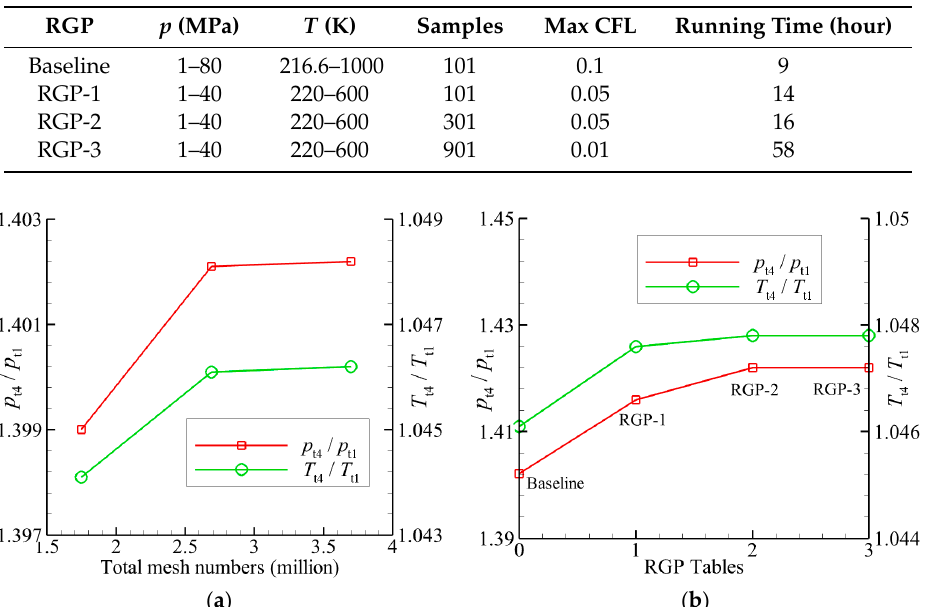
Table 2. Four types of RGP tables with the corresponding maximum Courant–Friedrichs–Lewy (CFL) numbers to achieve a convergent solution under design condition.